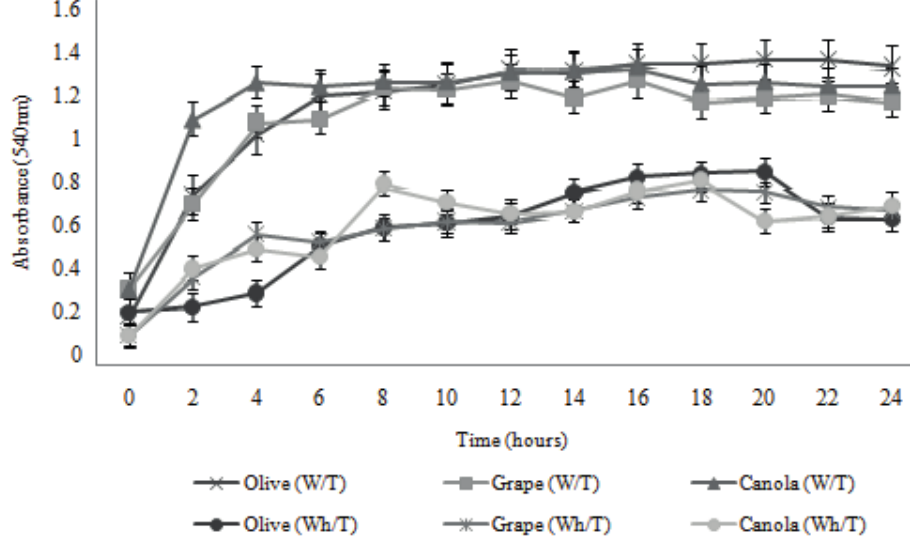
Figure 1 - G40 isolate growth curves in submerged culture with olive oil, grape seed oil, and canola oil as carbon source, with and without the addition of Tween 80. The experiment was performed in orbital shaker, at 30 ºC for 24